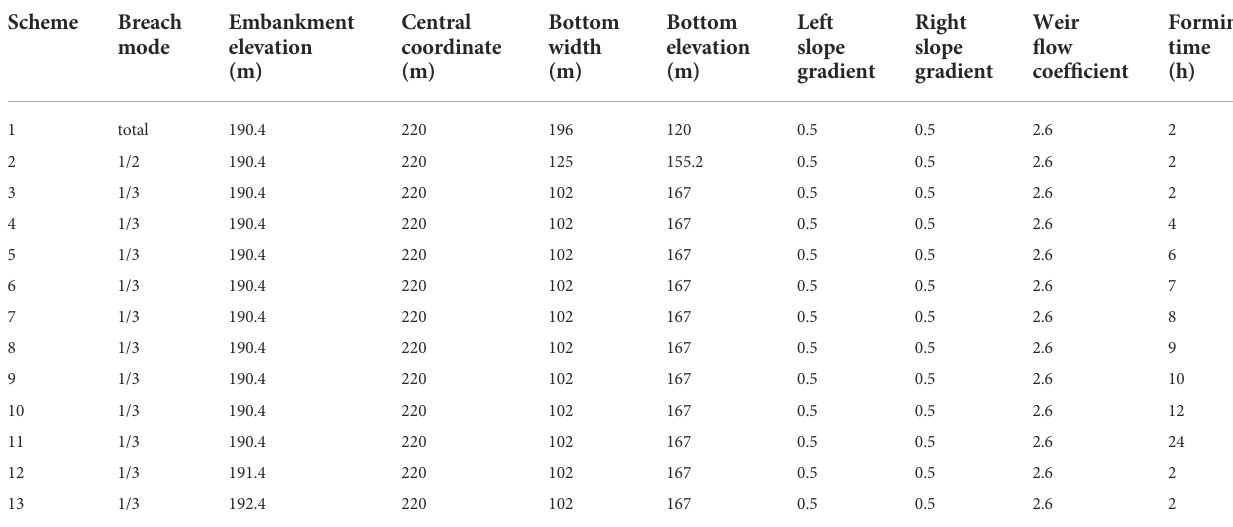
TABLE 1 Chengbi River Reservoir dam-break scheme